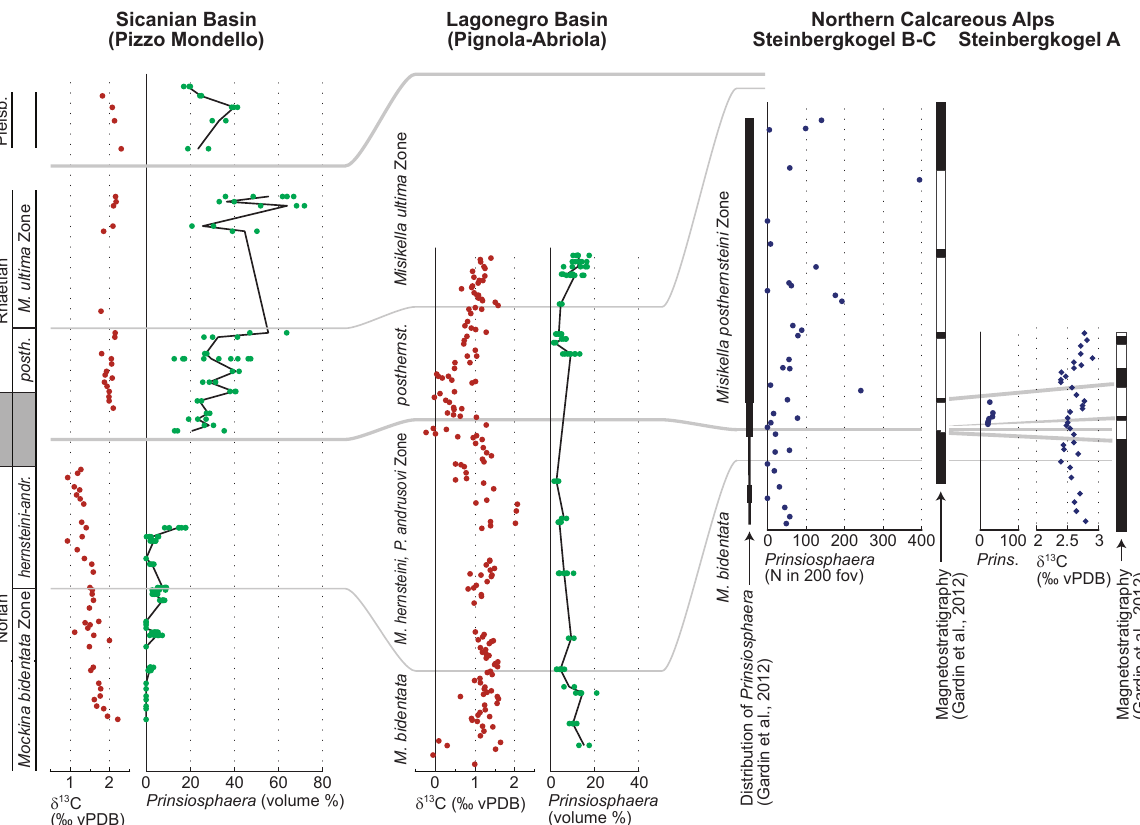
Fig. 9. Correlation of isotopic and nannofossil records between Pizzo Mondello, Pignola-Abriola and Steinbergkogel (Gardin et al., 2012). The correlation with Steinbergkogel is only based on conodont biostratigraphy, and it could thus be inaccurate, as highlighted by Giordano et al. (2010). Distribution of Prinsiosphaera and magnetostratigraphy at Steinbergkogel are reported as in Gardin et al. (2012). Blue dots are obtained from Table 4 in Gardin et al. (2012). Stable carbon isotopes from Krystyn et al. (2007). FOV: fields of